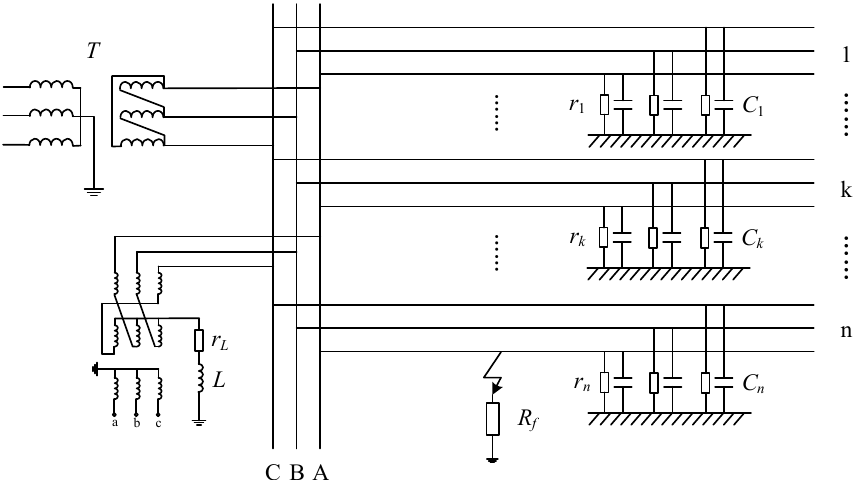
Figure 1. A phase-to-ground fault in the resonant grounded distribution system, where T is the HV/MV transformer, and R f is the fault resistance. C is the equivalent capacitance of the system. r is the equivalent resistance of the system. L is the equivalent inductance of the arc suppression coil.